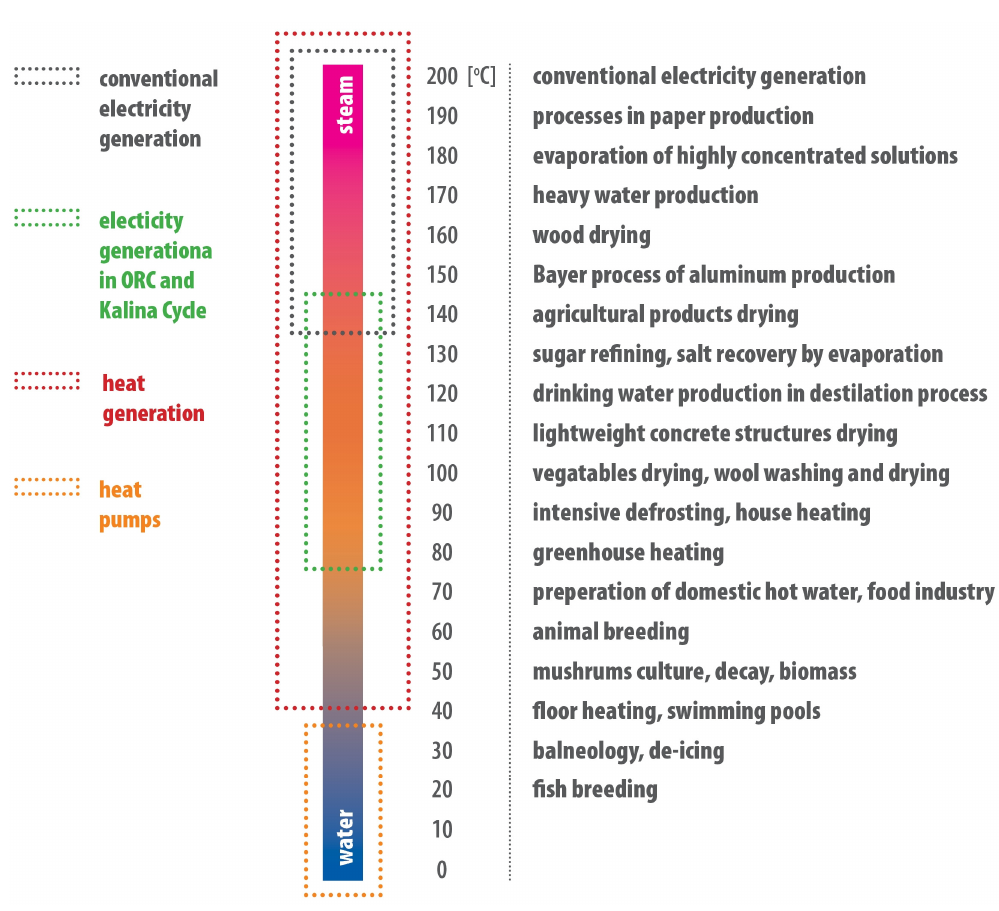
Figure 1. Modified Lindal diagram (based on [1,2]).